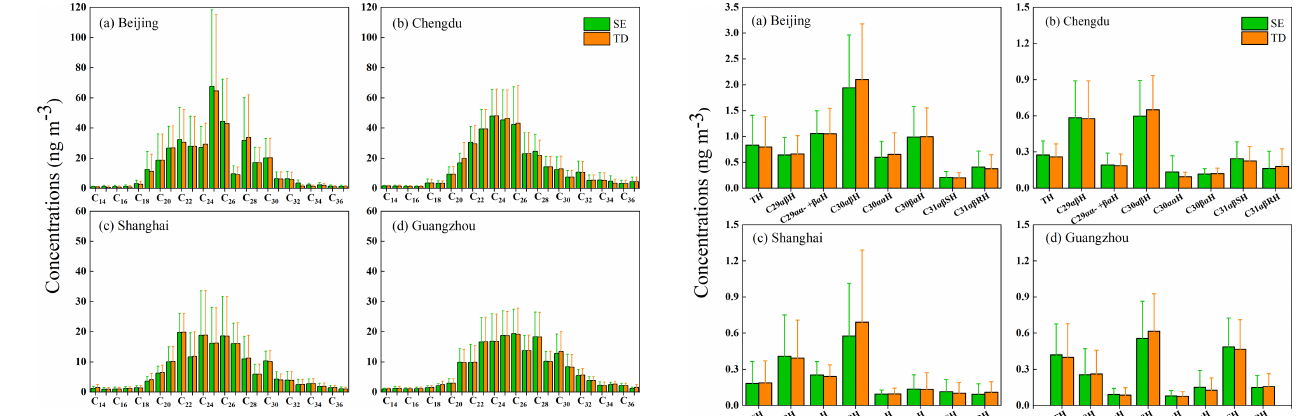
Figure 4. Average concentration of n-alkanes (n-C 14 –n-C 37 ) deter- mined by SE-GC-MS and TD-GC-MS methods during wintertime from December 2013 to January 2014 in Beijing (a) , Chengdu (b) , Shanghai (c) and Guangzhou (d) . Error bar is one standard devia- tion of individual n-alkanes.